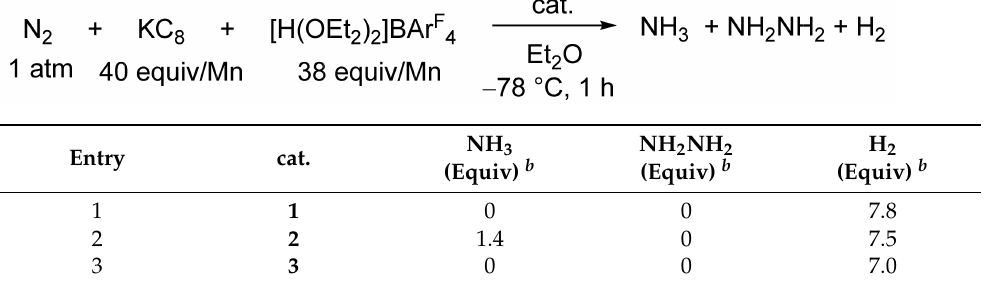
Table 4. Attempted catalytic reduction of dinitrogen into ammonia or hydrazine using 1 – 3 at − 78 ◦ C a .